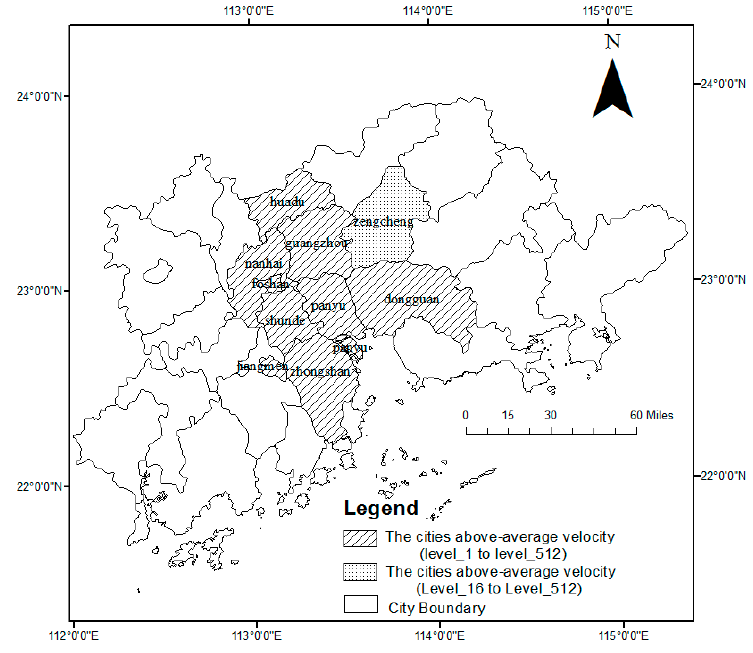
Figure 6. Major cities in the PRD with above-average urbanization velocities for the years 2000 to 2015.